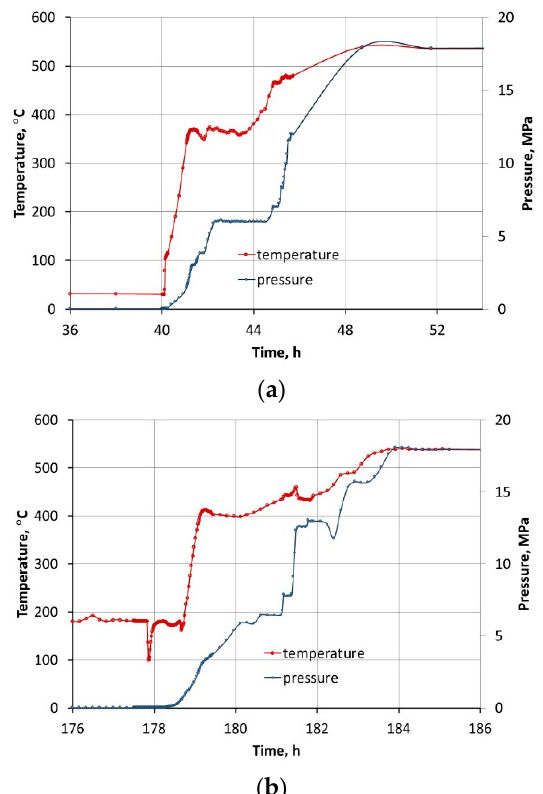
Figure 3. Graphs of temperature and steam pressure changes in the pipeline with a Y-shaped junction for ( a ) the cold and ( b ) the hot startup periods.